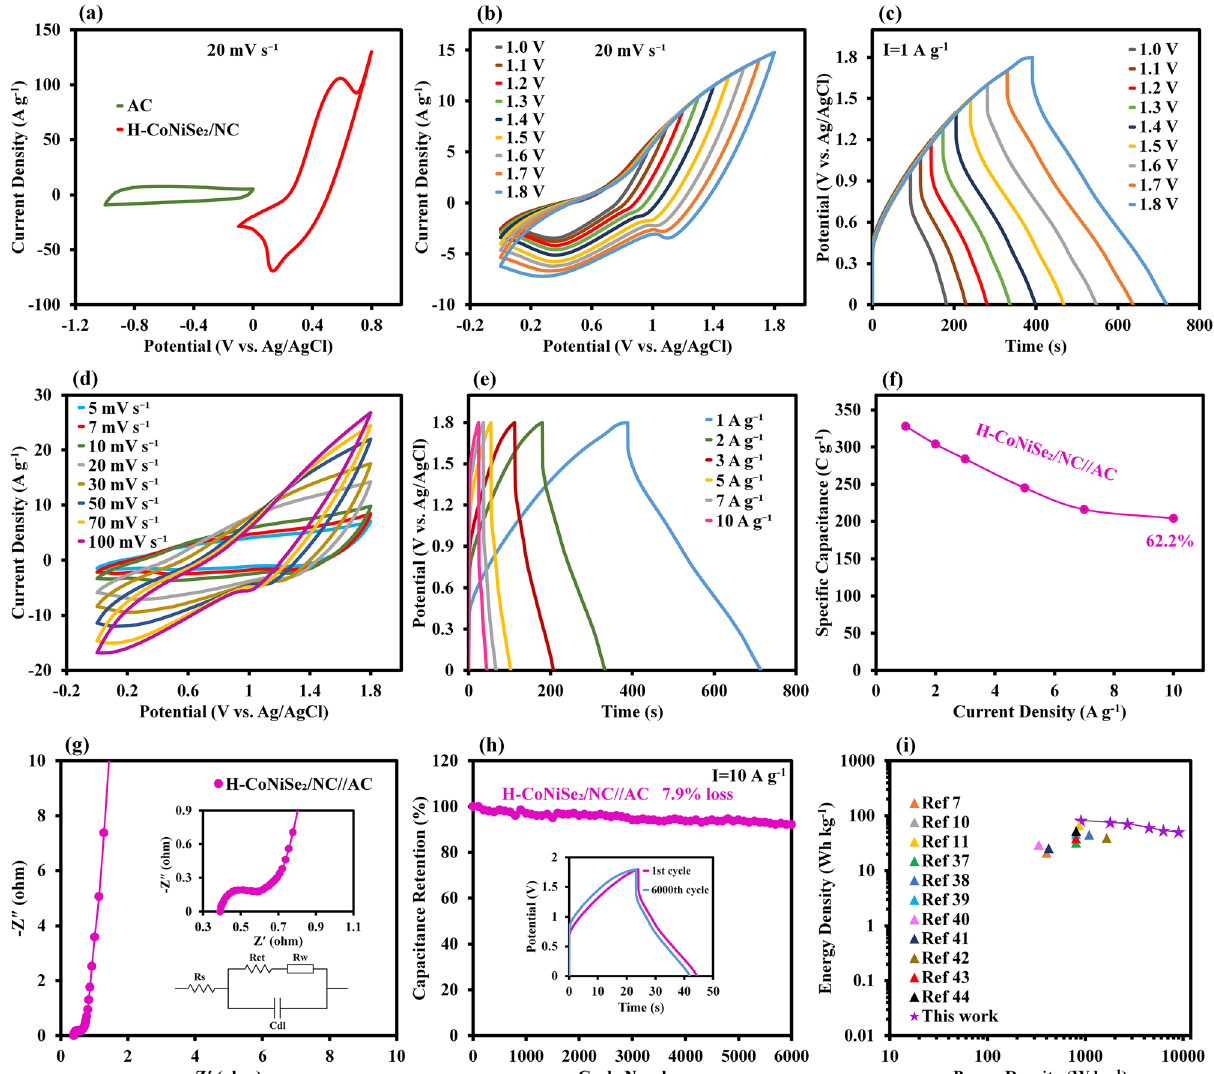
Figure 7. ( a ) CV curves of AC and H-CoNiSe 2 /NC at 20 mV/s in a three-electrode system. ( b ) CV curves of H-CoNiSe 2 /NC//AC at 20 mV/s at various potential windows. ( c ) GCD curves of H-CoNiSe 2 /NC//AC at 1 A/g at various potential windows. ( d ) CV curves of H-CoNiSe 2 /NC//AC at various scan rates. ( e ) GCD curves of H-CoNiSe 2 /NC//AC at various current densities. (f ) Specific capacitances of H-CoNiSe 2 /NC//AC at 1 to 10 A/g. (g) Nyquist plot of